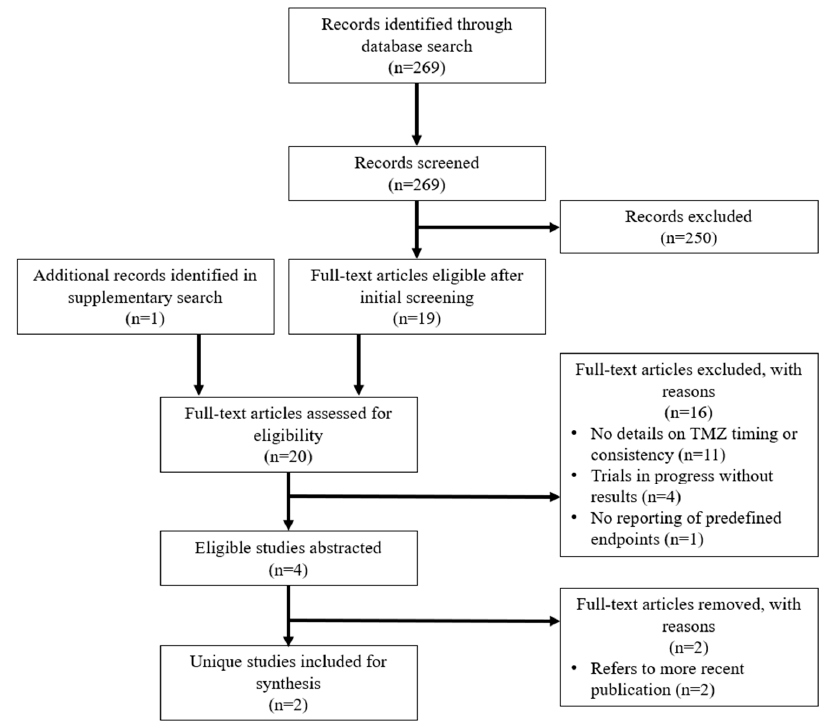
Figure 1. Flowchart of study screening and inclusion for abstraction.